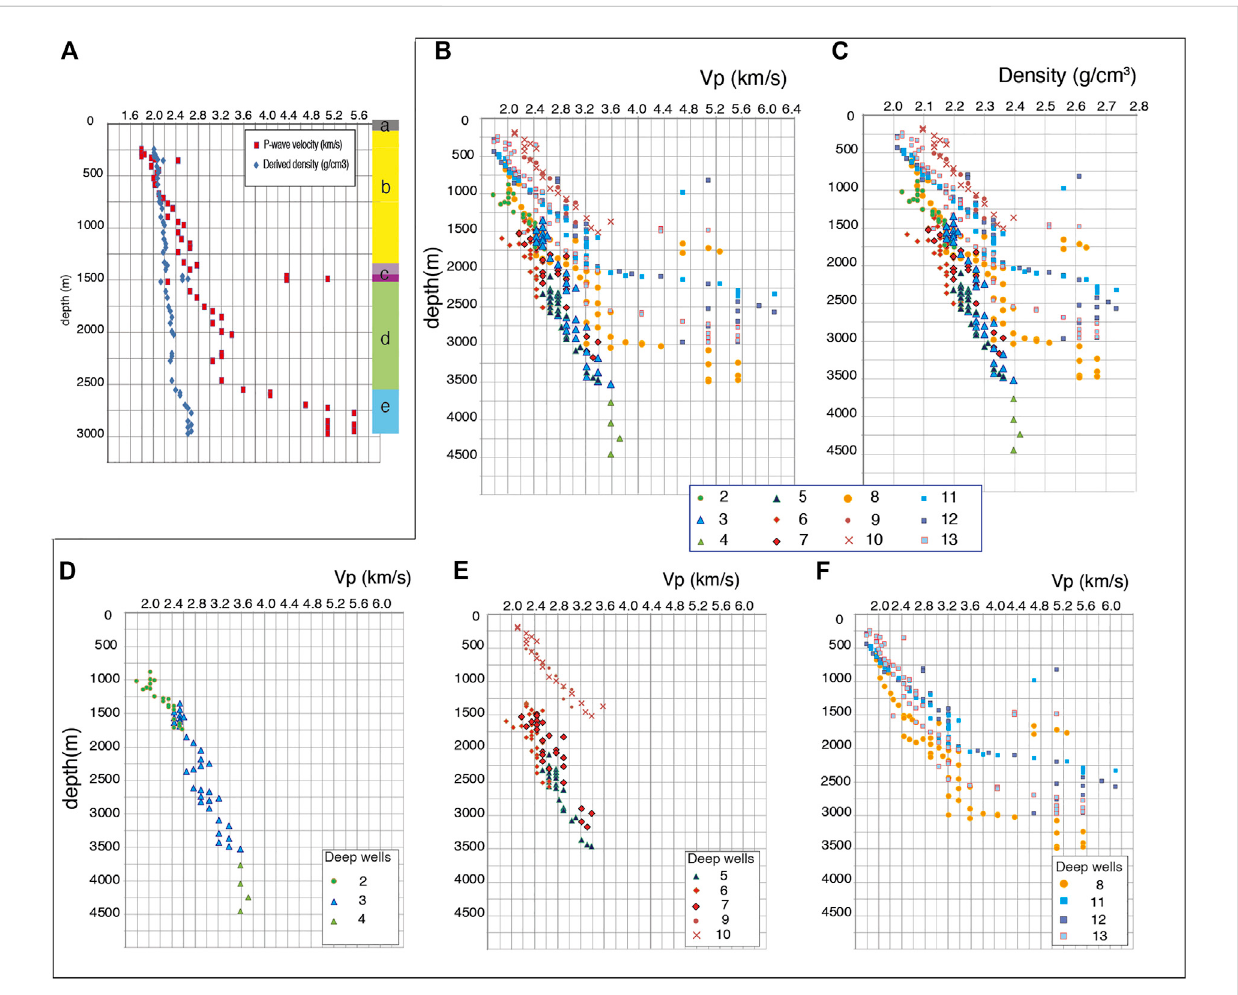
FIGURE 2 (A) Lithostratigraphic column for the deep well n. 13, P-wave velocity and derived density respect to: a) non-de fi ned interval; b) Plio-Pleistocene deposits, mainly marine clays and sands in different combinations, including a Conglomerate level (between 243 and 446 m); c) Messinian group, sand, clay, and sandstone with gypsum (dark purple represents the Gessoso-Sol fi fera Formation); d) Eo-Miocene units, marly — calcareous-siliceous succession; e) Cretaceous-Eocene, mainly calcareous sequence (Scaglia Formation). (B) P-wave velocity and (C) density vs. depth of 12 analyzed wells. (D) Northernareawells. (E) Wells closest to theseismic sequence and onland wells. (F) Southernareawells.Eachdata point isrelativeto adifferent rock thickness and plotted at the bottom depth of the interval. Depth refers to sea